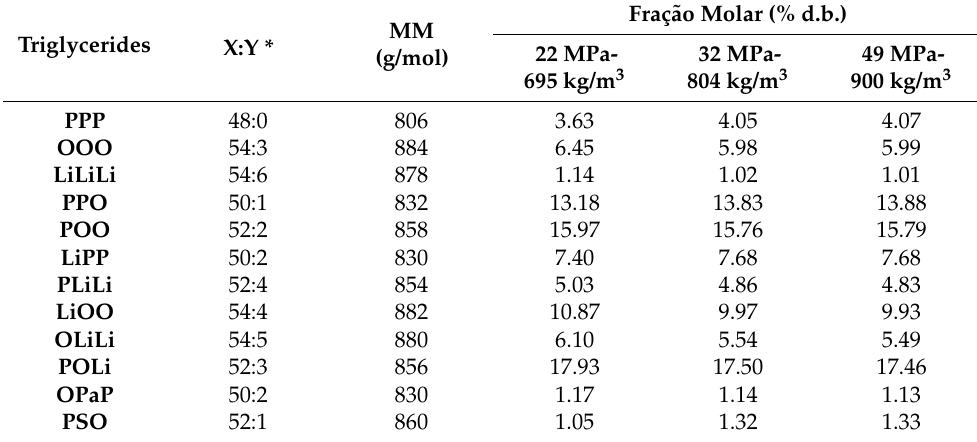
Table 3. Prediction of triglyceride composition of the oils of murici pulp ( B. crassifolia ) obtained by CO 2 -SFE at 343.15